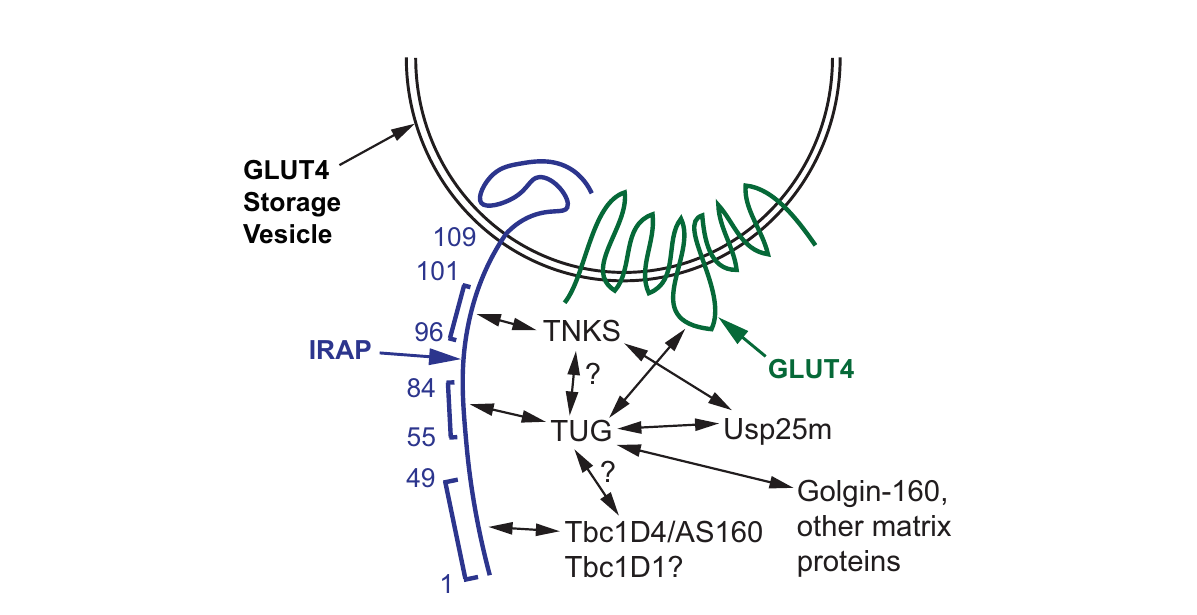
FIGURE 3 Proteins that bind and regulate GLUT4 Storage Vesicles (GSVs). A GSV membrane containing IRAP and GLUT4 is shown, and amino acid residues in the cytosolic N-terminus of IRAP are numbered. Tankyrase (TNKS), TUG, and Tbc1D4 (AS160) bind to adjacent peptides in IRAP, as indicated by brackets. TUG also binds the large intracellular loop of GLUT4, and both TUG and TNKS bind Usp25m. Direct binding of TUG to TNKS and to Tbc1D4 has not been shown; these hypothesized interactions are indicated with question marks. Tbc1D1 binds the cytosolic domain of IRAP (residues 1-109), but this interaction has not been localized further; the question mark indicates that it is hypothesized to bind IRAP residues 1-49 similar to Tbc1D4. TUG binds to Golgin-160 and other Golgi matrix proteins through its C-terminus, which is required to trap the vesicles intracellularly in the absence of insulin